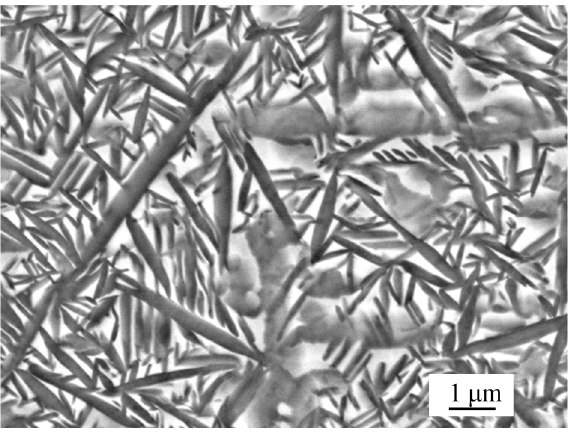
Figure 1. Material microstructure imaged by SEM (10 K×)